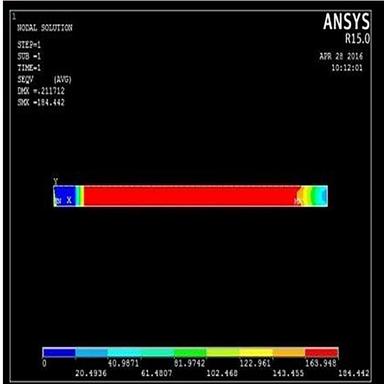
Simulation Results of Tensile Test Specimen at load 4708.8 N.